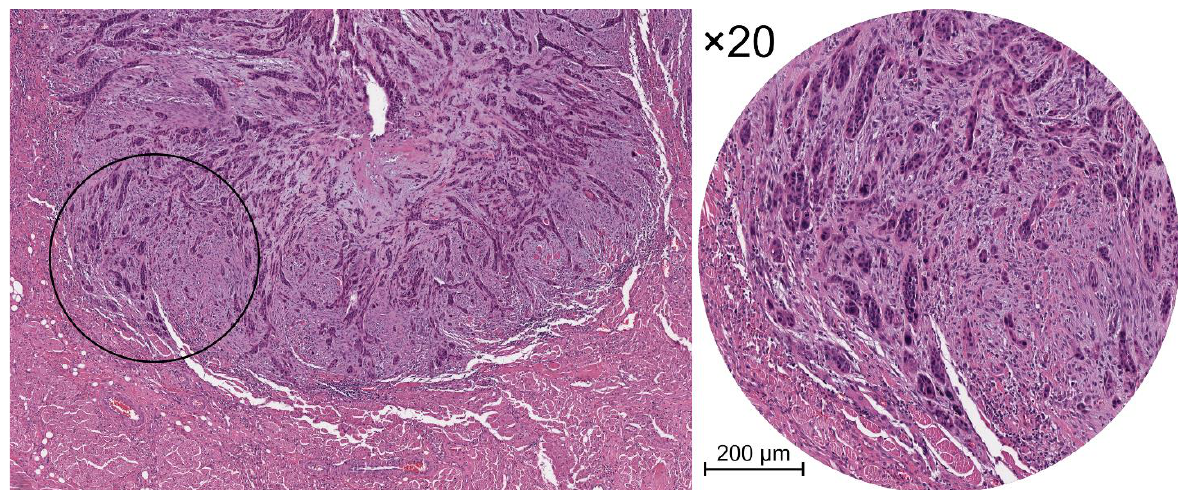
Figure 1. Histological views of tumor budding in H&E-stained sections of OSCC. Left panel: infil- trative tumor front at low magnification. Right panel: the inset shows a part of the same images at higher magnification (×20).